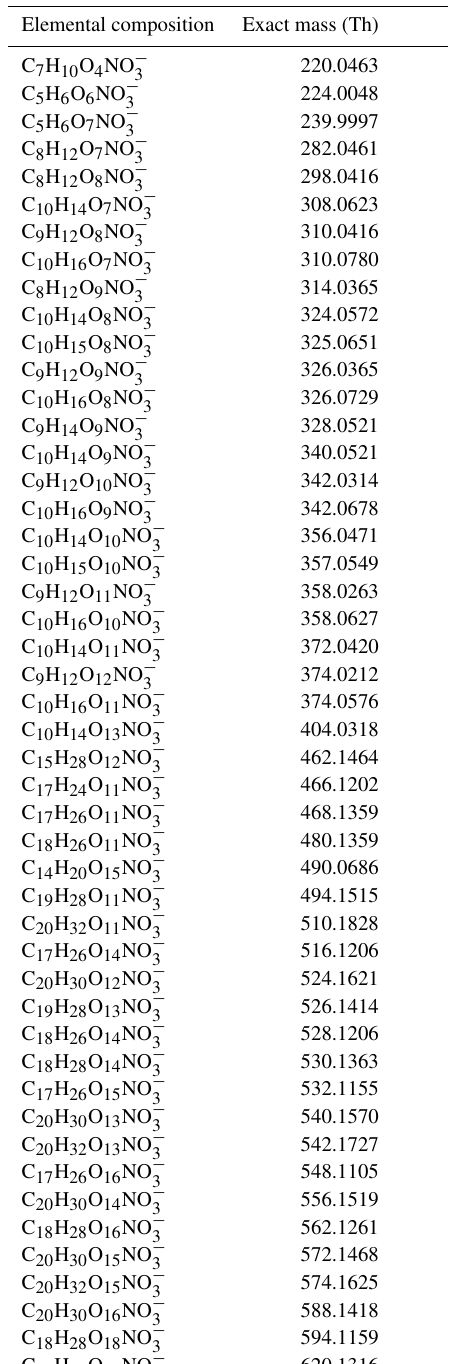
Table A1. The elemental compositions and exact masses of the most abundant isotopes of the HOM compounds that were added together to make the total